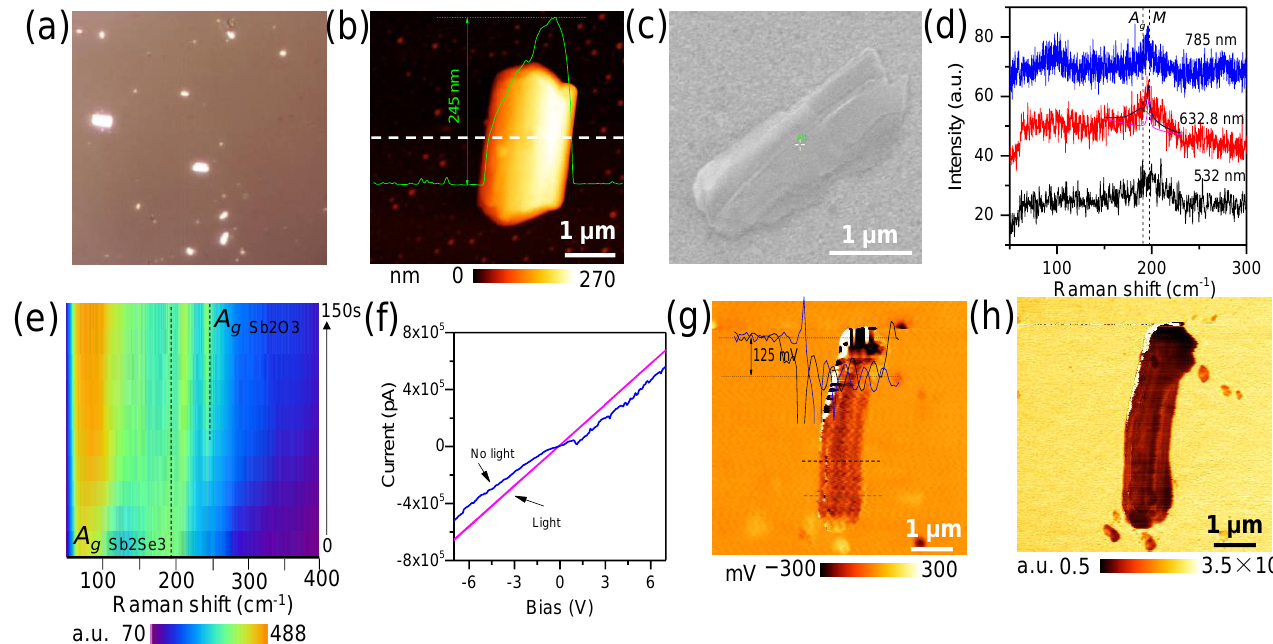
Figure 2. ( a ) Optical image of a Sb 2 Se 3 flakes prepared on mica substrate. ( b ) AFM topography image of a Sb 2 Se 3 nanoflake. Height profile along the white dashed line is plotted as an inset. ( c ) SEM image of a Sb 2 Se 3 nanoflake transferred to Au coated substrate. ( d ) Raman spectra of Sb 2 Se 3 nanoflakes measured using 532, 632.8, and 785 nm lasers at 3.5, 2.4, and 35 μW. The Raman peak at ~200 cm − 1 was deconvoluted into the A g peak of Sb 2 Se 3 and the mica peak (M) using two Lorentzian functions. ( e ) Excitation time-dependent Raman spectra of a Sb 2 Se 3 nanoflake. Excitation laser wavelength 532 nm; laser power 34 µ W. ( f ) I-V curve of a Sb 2 Se 3 nanoflake transferred to Au-coated substrate with and without a laser (532 nm). ( g ) CPD image of a Sb 2 Se 3 nanoflake; the CPD profiles along the black and blue lines are plotted as insets. ( h ) Capacitance image of the Sb 2 Se 3 nanoflake in ( g ). The I-V curve of a Sb 2 Se 3 nanoflake prepared on gold thin film (topography image